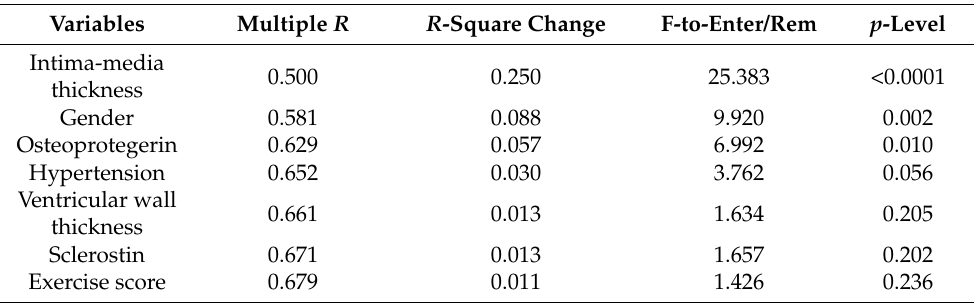
Table 3. ( A ) Multivariate linear regression analysis of the factors that were correlated with arterial stiffness (PWV) in the overall patient group ( n = 78). ( B ) Multivariate linear regression analysis of the factors that were correlated with arterial stiffness in the PWV lo group ( n =